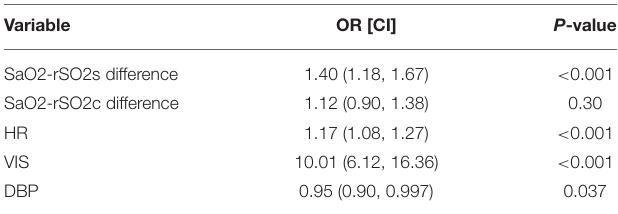
TABLE 6 | Odds ratio of cardiac arrest of individual variables of multivariate model at 1h prior to cardiac